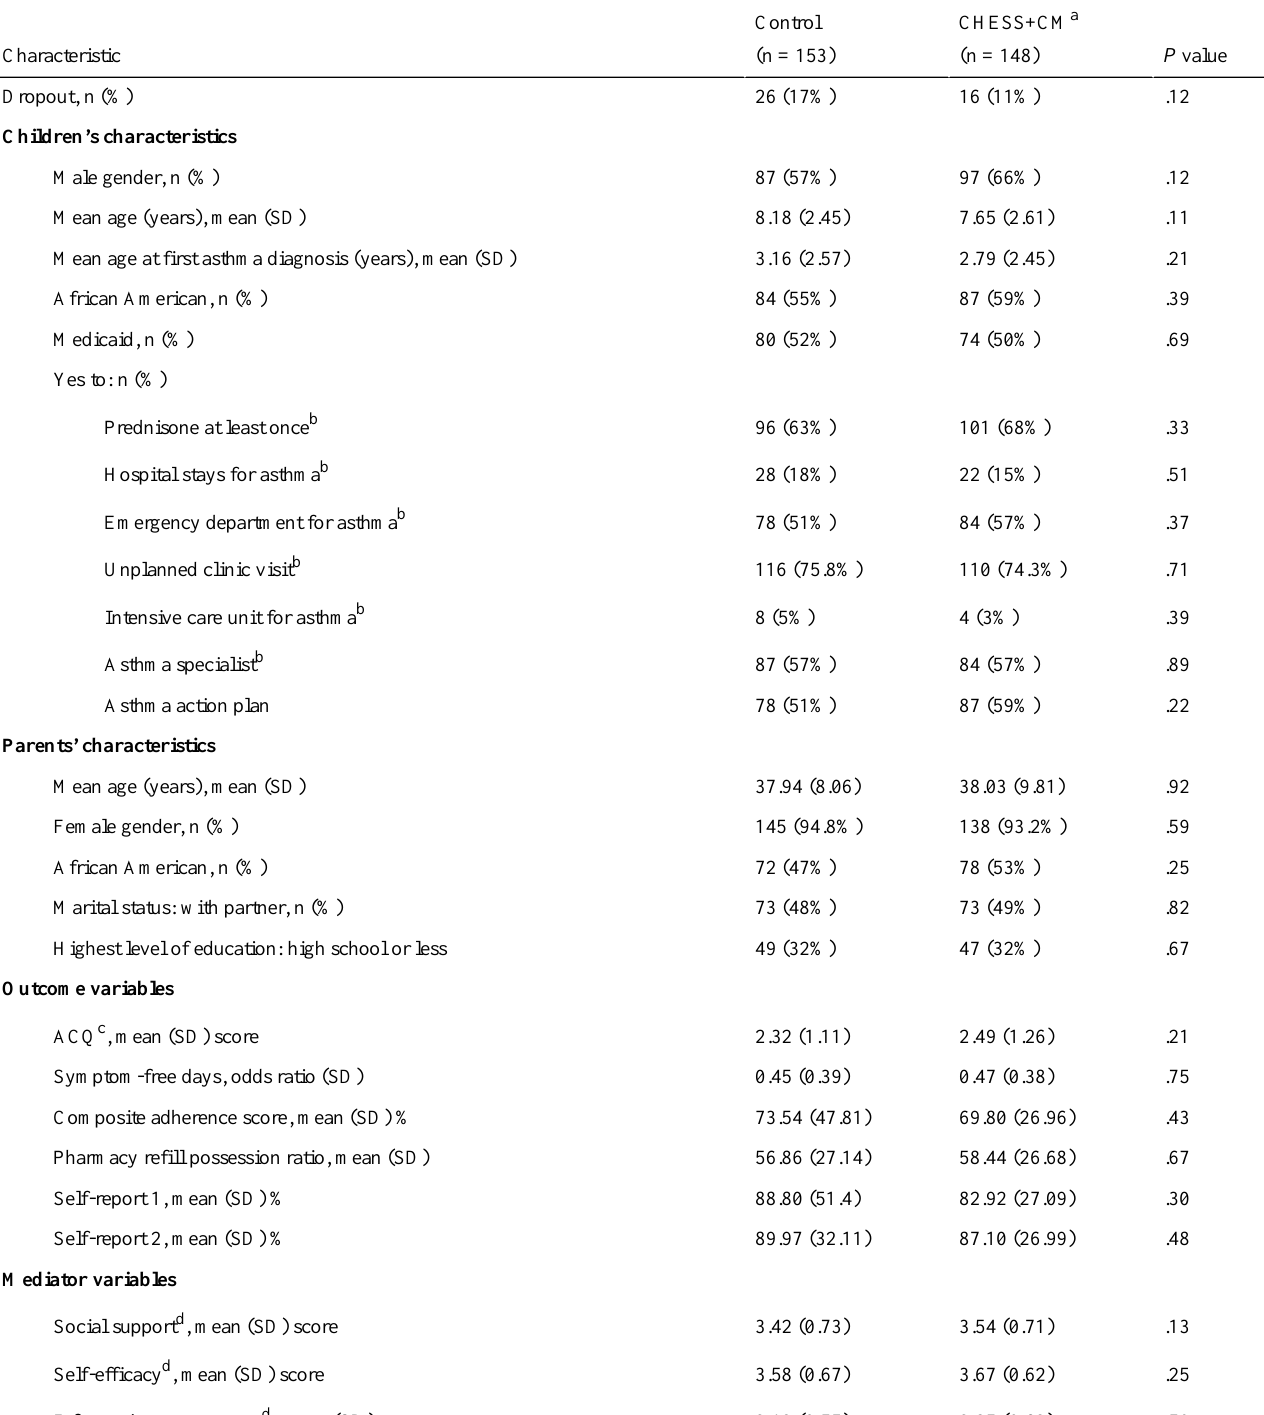
Table 2. Mean baseline values for demographics and main outcome and mediator